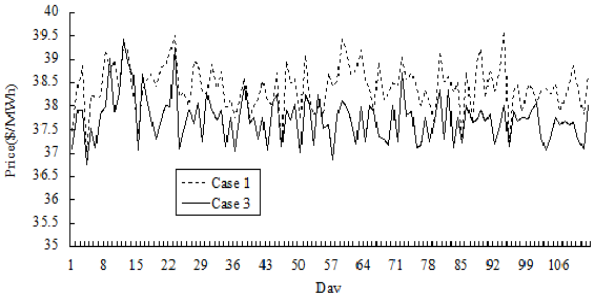
Figure 3. Comparative results of price variation for Cases 1 and 3 (for 112 days).